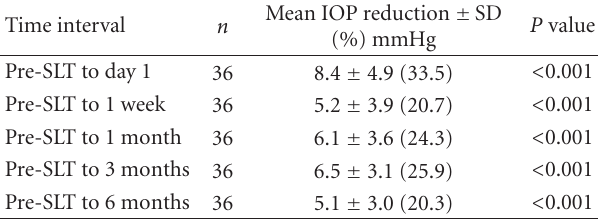
Table 3: IOP reduction from baseline at each time interval in primary open angle group (Group B).